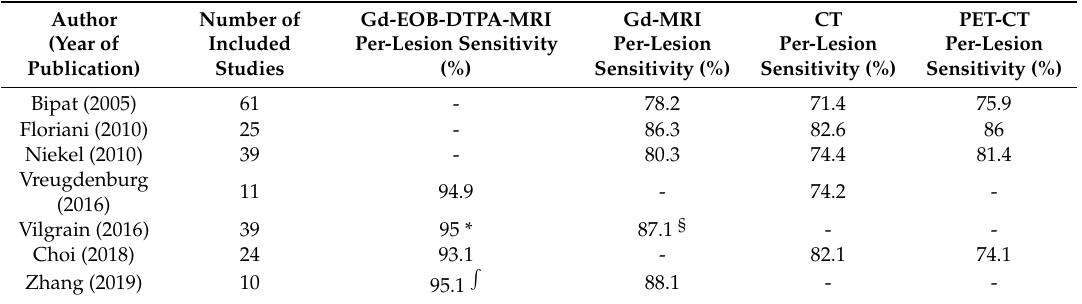
Table 1. Per-lesion sensitivity of EOB-MRI, Gd-MRI, CT, and PET / CT for diagnosing colorectal liver